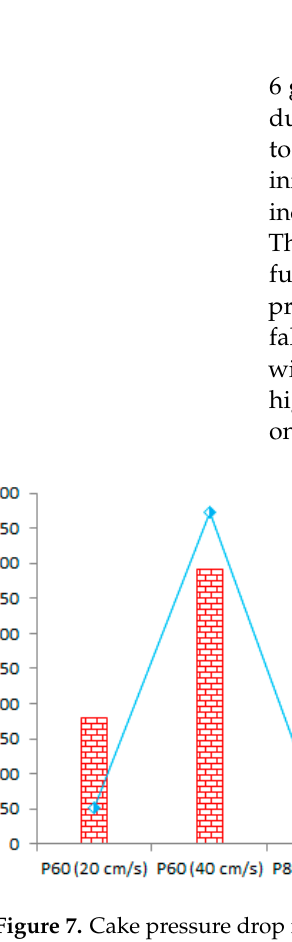
Figure 7. Cake pressure drop increase per gram of dust deposited and a ratio of DHC to total mass of dust dosed ( M ) for different membranes at different permeate velocities at a constant loading rate of 4 g/h ( a ) and P80 membrane at 20 cm/s at different loading rates ( b ).